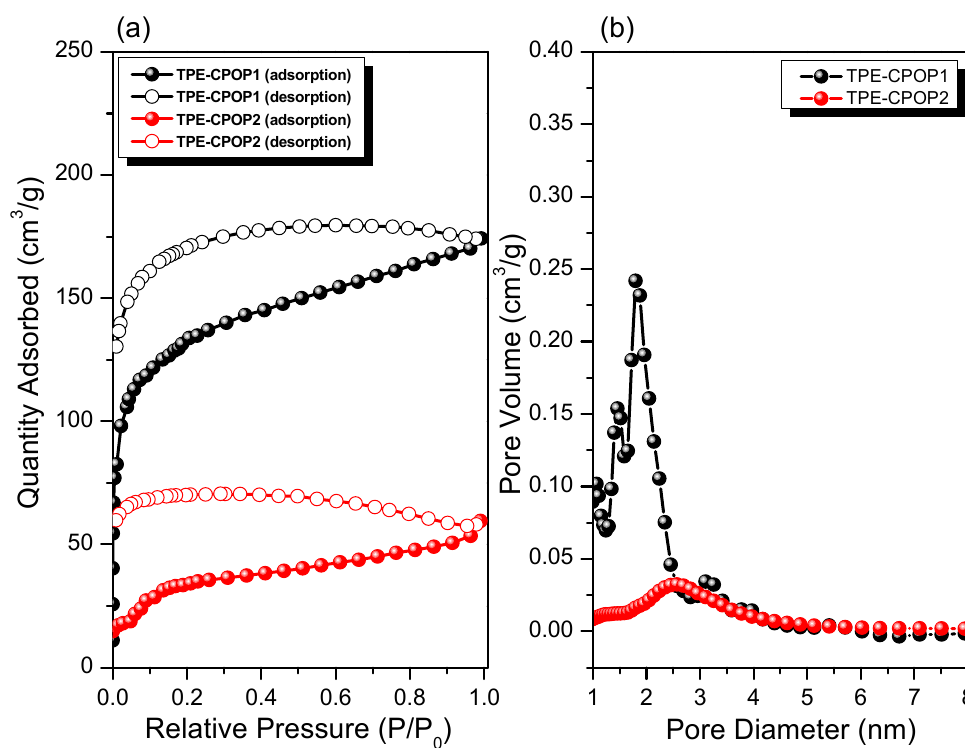
Figure 5. ( a ) N 2 adsorption desorption pattern (filled cycles: adsorption; empty cycles: desorption) and ( b ) pore size diam- eter of TPE-CPOP1 and